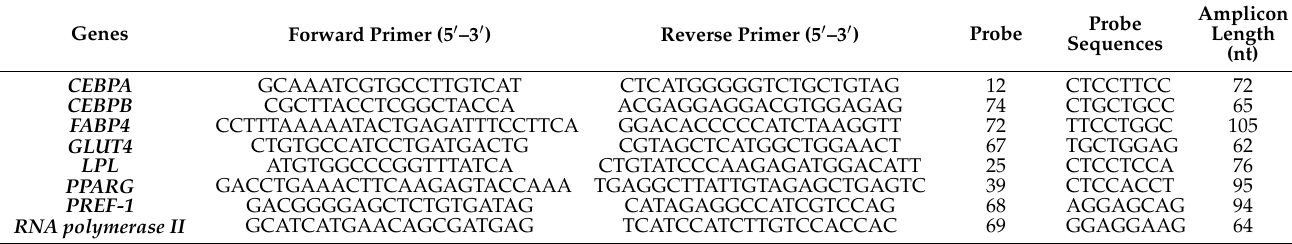
Table 1. Primer sequences and